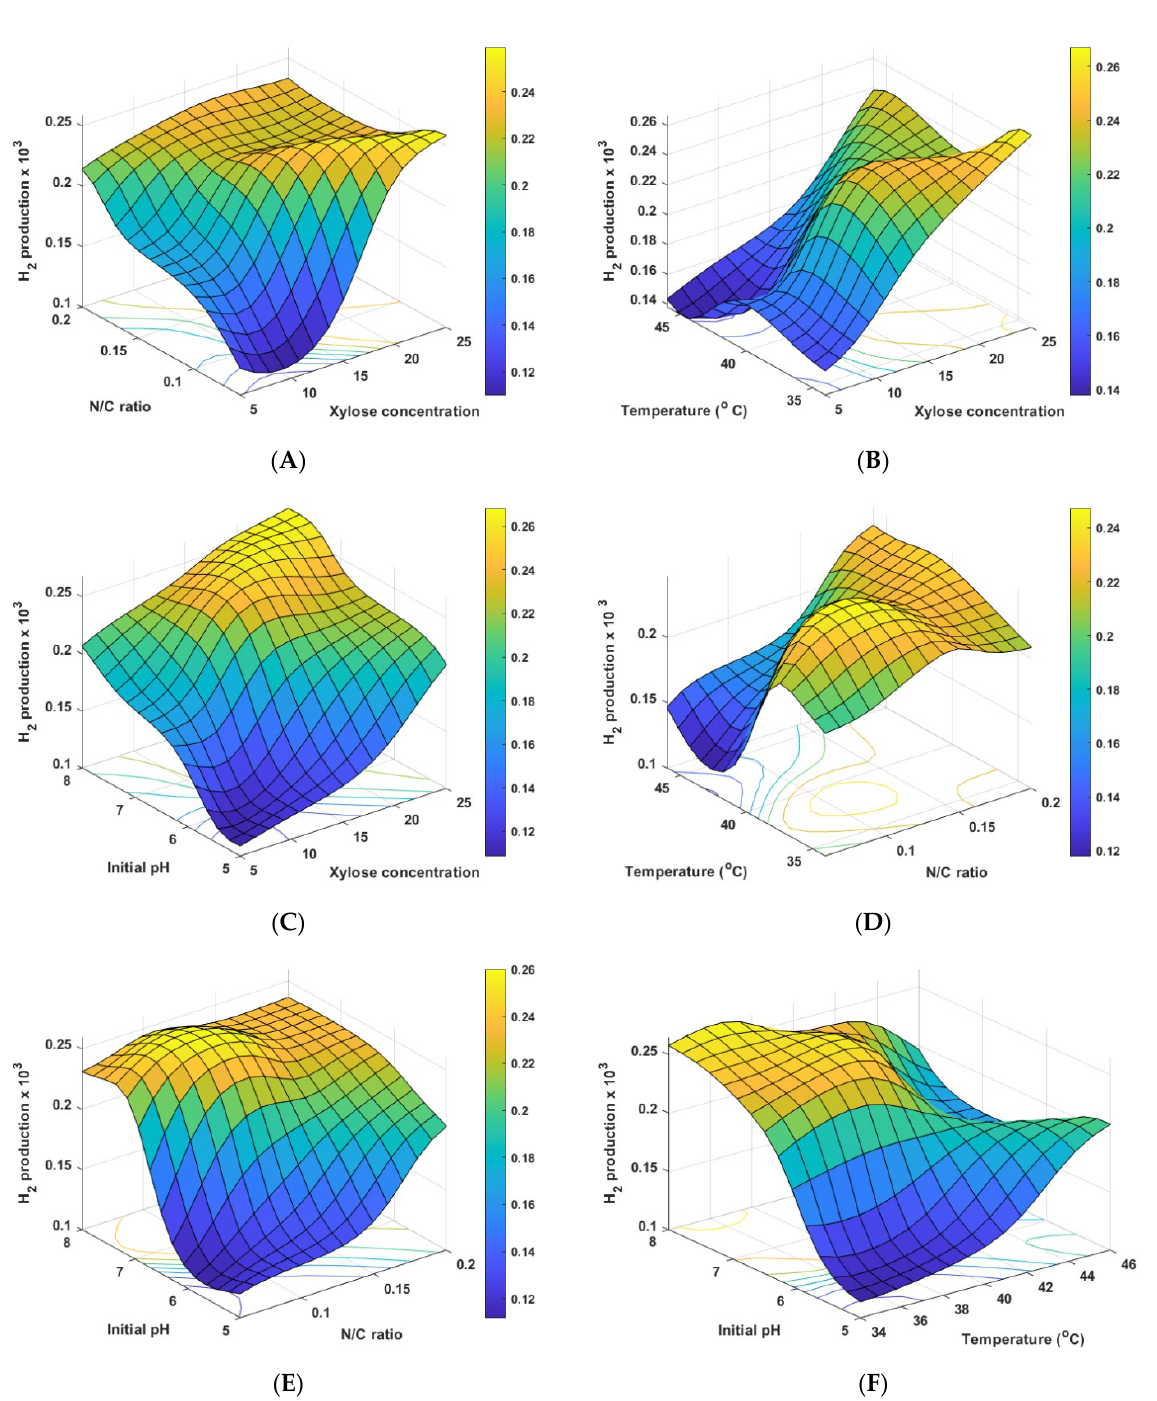
Figure 4. Effect of various operational parameters on the hydrogen production and xylose consump- tion: ( A ) N/C ratio and xylose concentration; ( B ) temperature and xylose concentration; ( C ) initial pH and xylose concentration; ( D ) temperature and N/C ratio; ( E ) initial pH and N/C ratio; ( F ) initial pH and